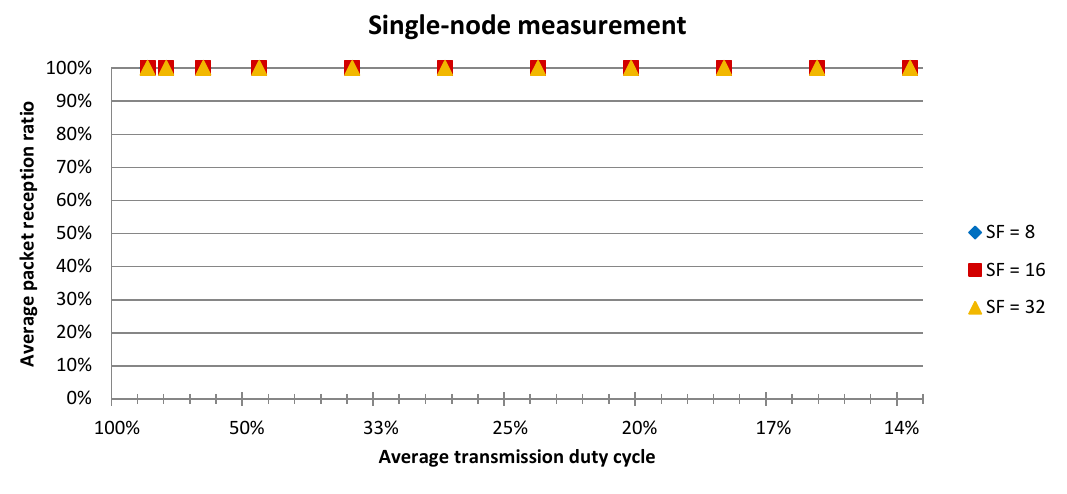
Figure 10. Packet reception ratio for the single-node setup under various traffic loads with spreading factors of 8, 16 and 32.